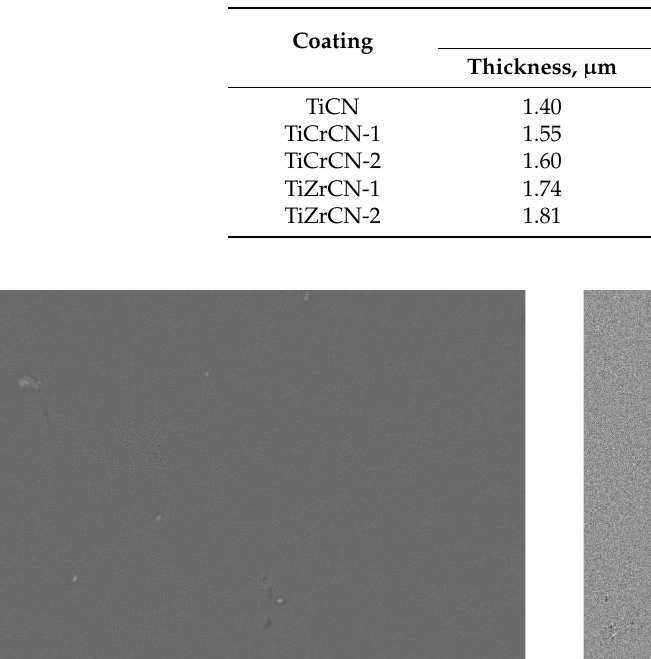
Coating Characteristics